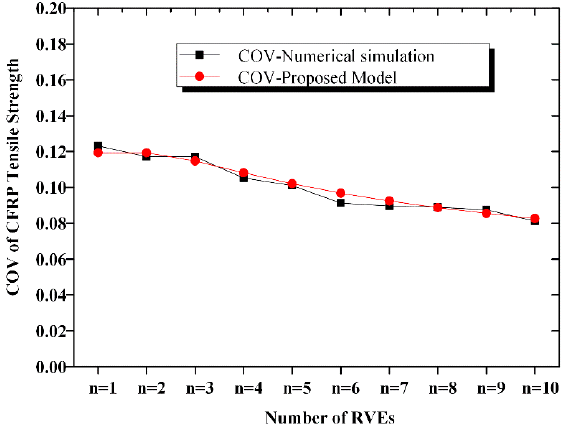
Figure 15. Comparison of COV of the CFRP strength of the n-element parallel system.